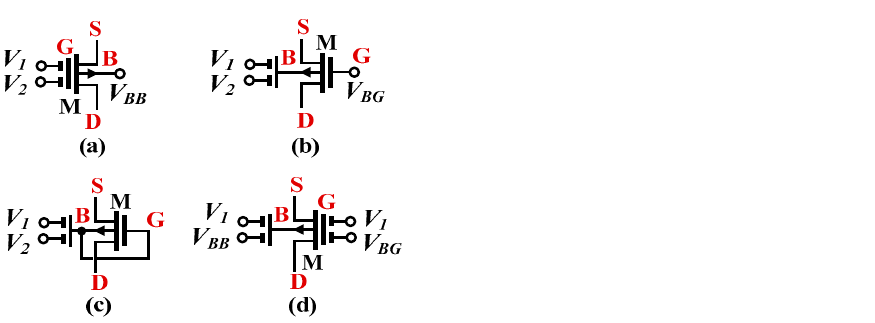
Figure 1. The conceptual diagram for processing biosignals.